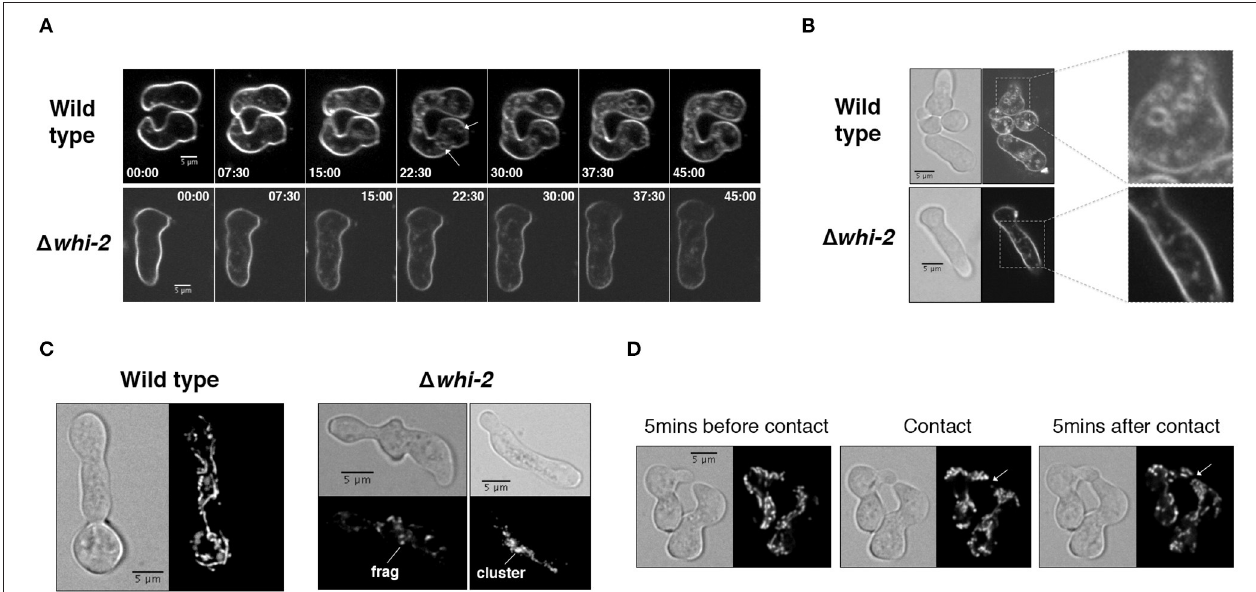
FIGURE 3 | Strains lacking whi-2 are defective in the accumulation of FM4-64-positive membranous structures and show defects in mitochondrial dynamics. (A,B) The uptake of FM4-64 via plasma membrane-derived structures was followed over time in wild type and 1 whi-2 germlings. A time course experiment is shown in (A) . Note the formation of large FM4-64-positive membranous structures in the wild type strain (arrows). Representative images after 30min of incubation are shown in (B) . These panels are complemented by Video 1 . (C) The organization of the mitochondrial network was examined using an ARG-4-GFP construct (Bowman et al., 2009 ). Note the appearance of fragmented (“frag”) and clusters (“cluster”) of mitochondria in 1 whi-2 cells. (D) Mitochondrial dynamics during cell fusion were evaluated by producing time-lapse videos of interacting wild type germlings. Note the absence of mitochondria at the fusion spot during the first minutes after contact (arrow). This panel is complemented by Video 2